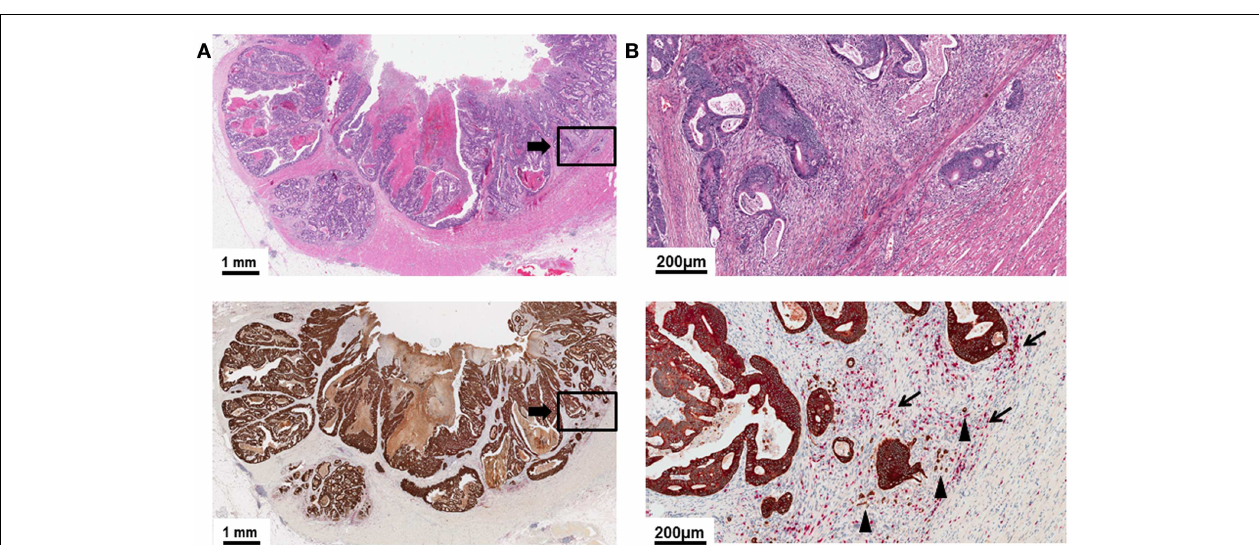
differentiated. Host tissue is displaced by expansile tumor growth. (B) High power detail (20 × ) of (A) . CD8 + lymphocytes are commonly observed (arrows).Tumor budding can be recognized as a superimposed feature but is generally infrequent (arrow heads).